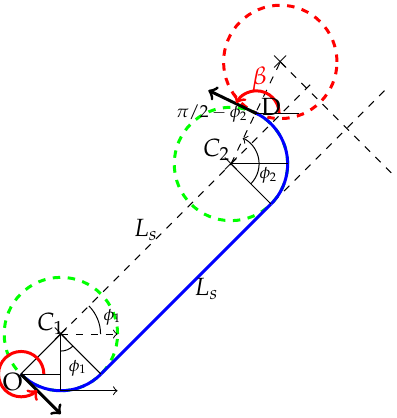
Figure 3. Left-Segment-Left Dubins Curve: The curve connects a start point with an orientation angle α and an end point with an orientation angle β . It is composed of a turn to the left around the first green circle, a segment of length L s , and a second turn to the left around the second green circle